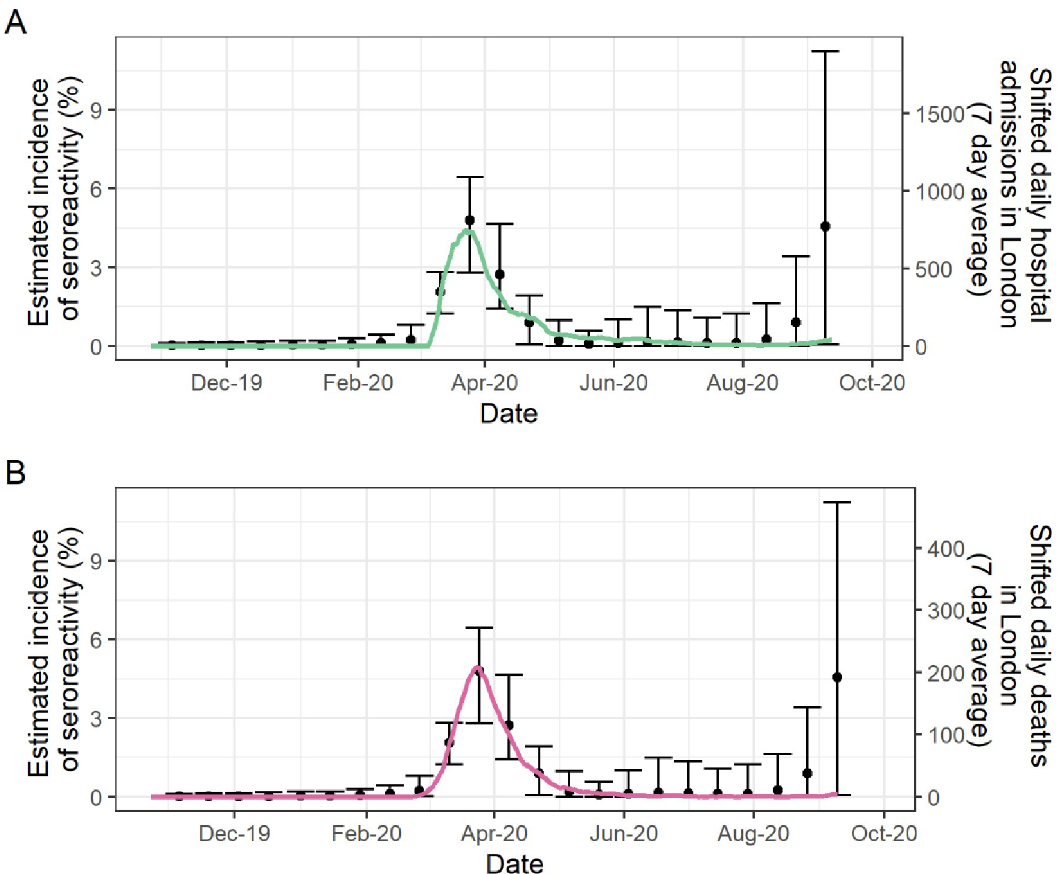
Fig 3. Estimated incidence of seroreactivity over time with 95% bootstrapped confidence intervals. (A) Seven-day averages of daily hospital admissions in London’ shifted by 10 days and scaled by 0.006. (B) Seven-day averages of daily deaths in London’ shifted by 13 days and scaled by 0.024. See Methods: Statistical analysis for further